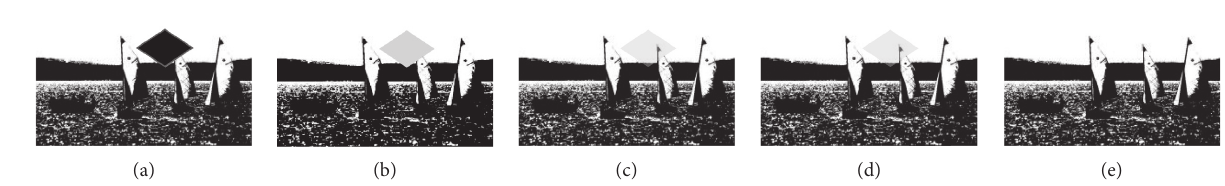
Figure 12: Comparison of the effect of structural repair binary image repair. (a) Original image, (b) Criminisi algorithm result, (c) adaptive repair algorithm result, (d) sparsity repair algorithm result, and (e) algorithm result of this paper.